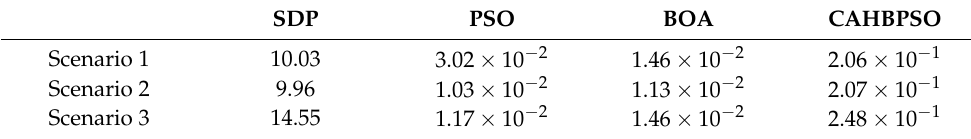
Table 4. The computation times on average for the methods under consideration. SDP PSO